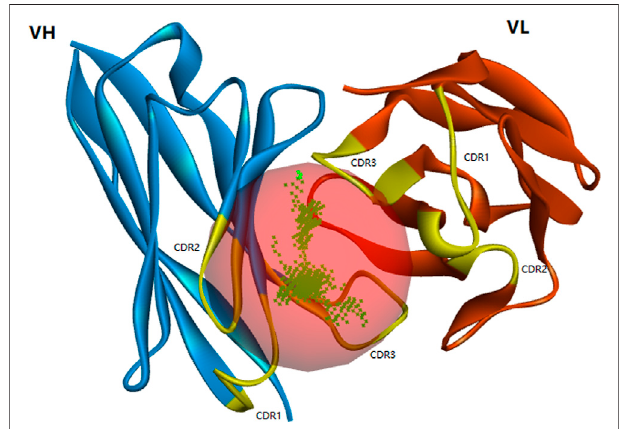
FIGURE 3 | Optimized spatial structure model of scFv (yellow highlights represent the distribution of CDR regions and red balls represent active cavity located in CDR regions).